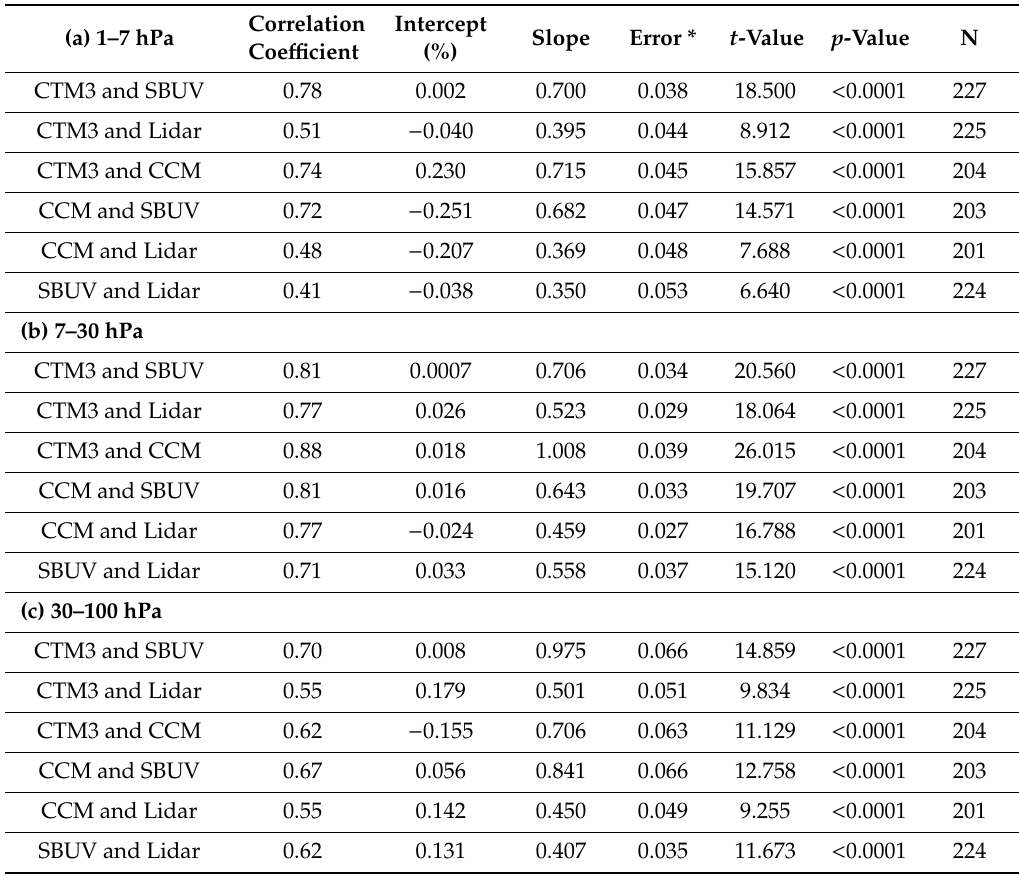
Table 3. Statistics of correlations between ozone from Oslo CTM3, EMAC CCM (SC1SD-base-02), SBUV (v8.6) and average lidar data anomalies at five stations in the: ( a ) upper stratosphere (1–7 hPa), ( b ) middle stratosphere (7–30 hPa) and ( c ) lower stratosphere (30–100 hPa). Seasonal and other known natural variability were removed from the data. For lidars, the upper stratospheric layers are confined between 3 and 7